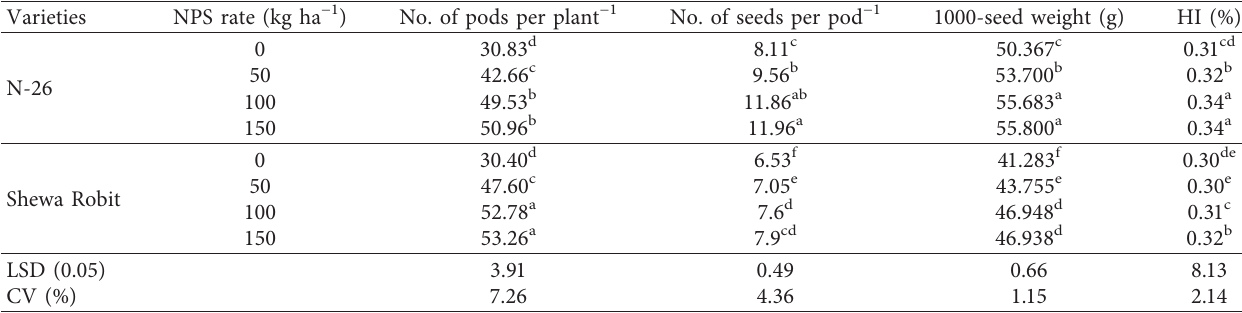
Numbers with the same letter(s) within a column are nonsignificant at P ≤ 0 . 05; CV � coefficient of variance and LSD � least significant